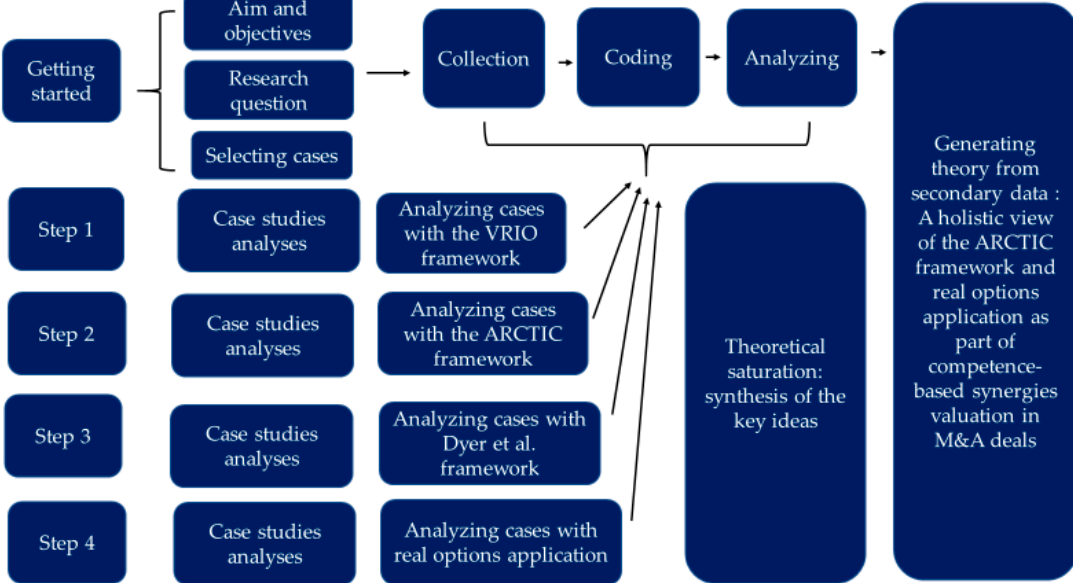
Figure 2. Creating theory from secondary data: the case studies process of the current paper, adapted from Arzuaga et al. (2014) and extended by the author.